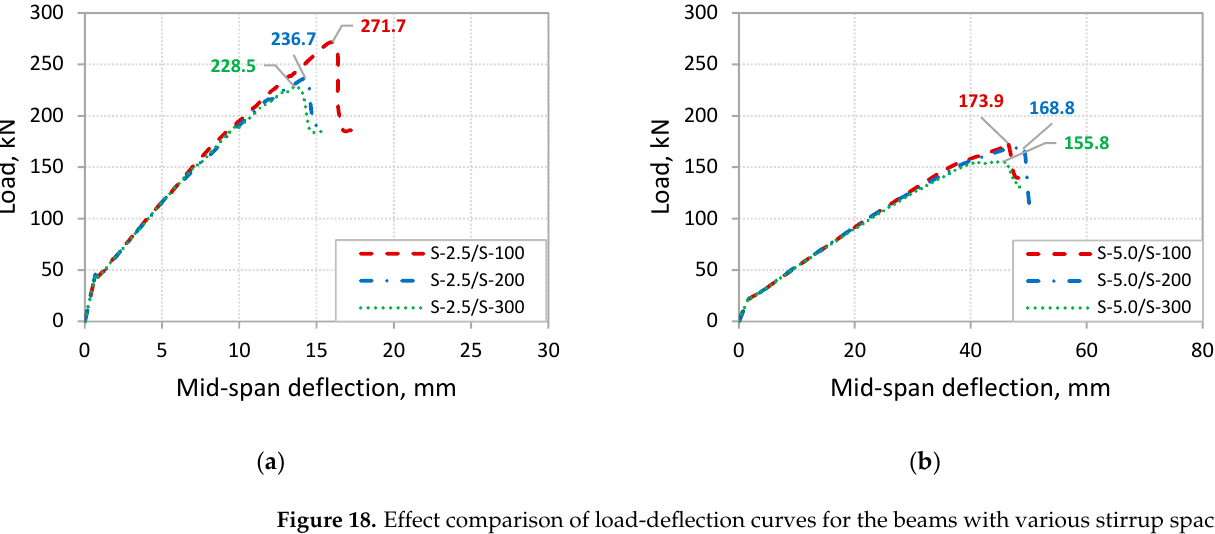
Figure 18. Effect comparison of load-deflection curves for the beams with various stirrup spacings: ( a ) beams with a v / d s = 2.5; ( b ) beams with a v / d s = 5.0.